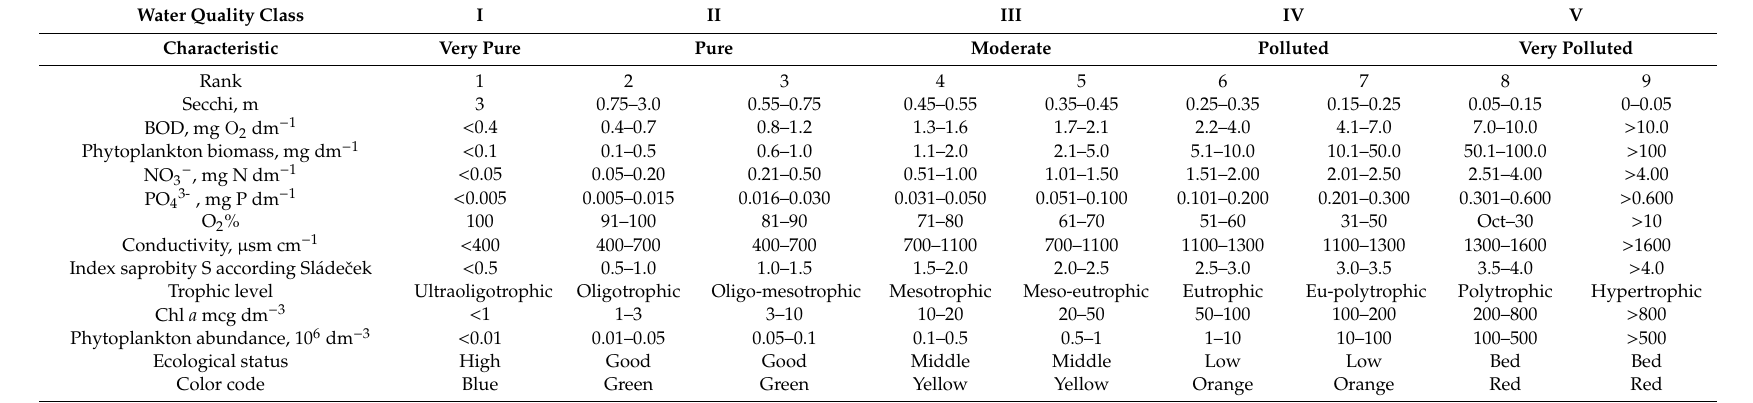
Table 2. Major trophic-related variables for freshwater aquatic ecosystems according to